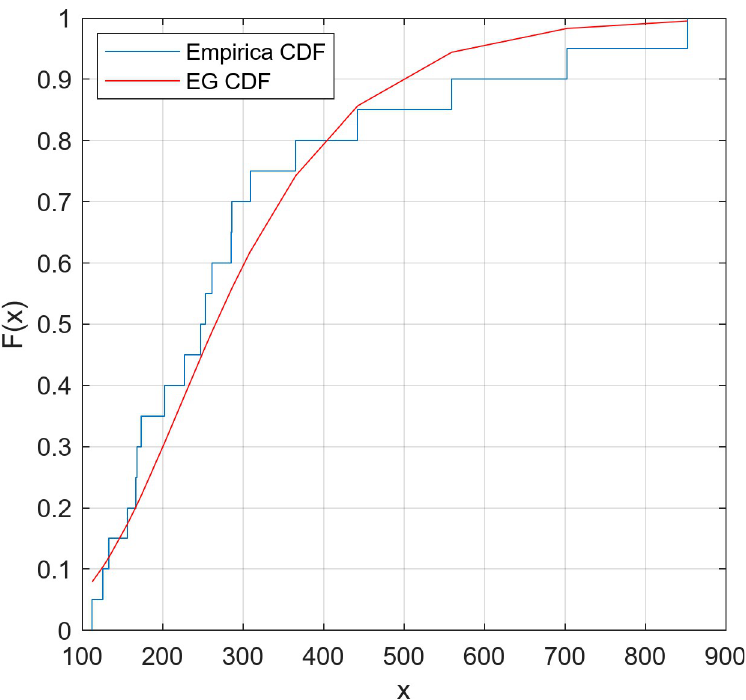
Fig 2. Empirical and fitted CDFs for Dataset